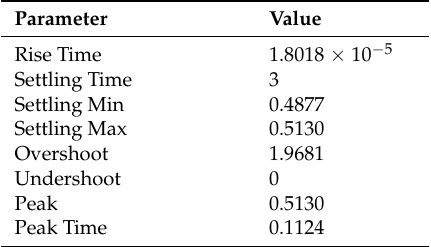
Table 7. Characteristics of the motor flux curve without using the correction